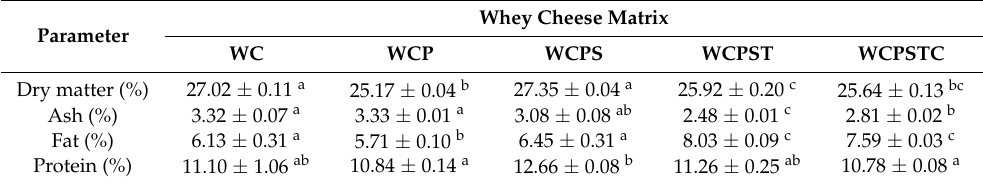
Table 4. Physicochemical composition of whey cheeses matrices (average ± standard